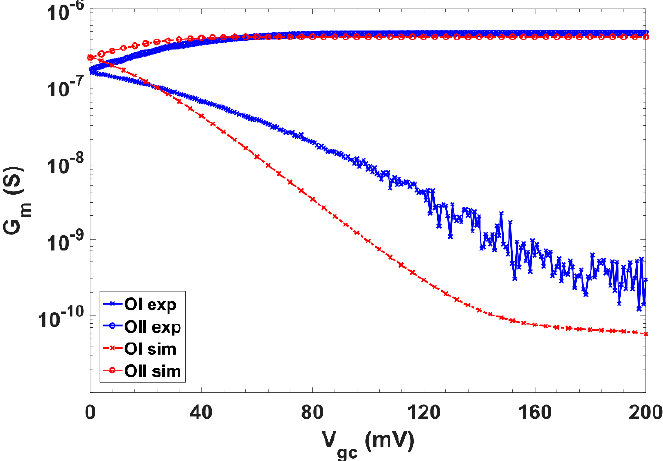
Figure 9. Experimental (blue) and simulated (red) G m variation over V gc for Filter-3. Figure 10 presents the cutoff frequencies for the tuning voltage V gc range with a 20 mV step. This V gc range ensures that the maximum offset of the output low pass filters is no greater than 1 %. The cutoff frequency, with a 500 nA bias current, can be tuned from 1.179 kHz (V gc = 0 V) down to 82.5 mHz (V gc = 200 mV) for Filter-1 (Figure 10a); from 1.475 kHz (V gc = 0 V) down to 94 mHz (V gc = 200 mV) for Filter-2 (Figure 10b) and for Filter-3 (Figure 10c) from 1.757 kHz (V gc = 0 V) down to 104 mHz (V gc = 200 mV). It is possible to reduce the bias current of Filter-2 and Filter-3 to further reduce the power consumption. This reduction keeps the minimum f c almost constant while the max- imum f c is reduced so if only low cutoff frequencies are needed, it is possible to save power. The maximum f c is reduced down to 680 Hz, 152 Hz and 8 Hz for Filter-2 (Figure 10b) and to 551 Hz, 140.6 Hz and 21.7 Hz for Filter-3 (Figure 10c) for bias currents of 250 nA, 100 nA, and 50 nA, respectively.